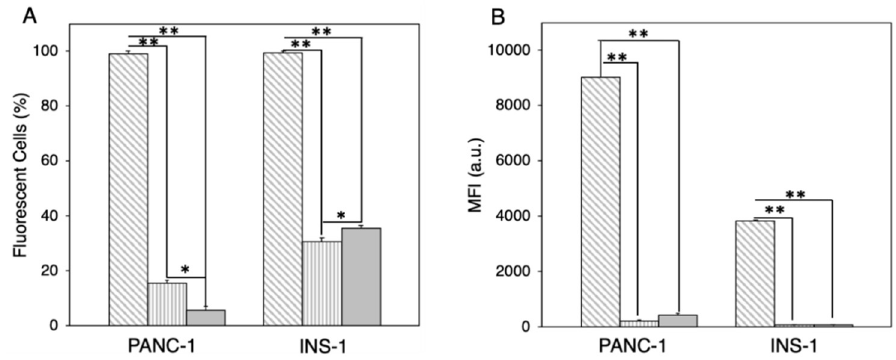
Figure 4. Relative protein abundance of biomolecular corona fingerprints. Lip-1 and Lip-5 were the liposomal formulations with the highest and lowest enrichment in PCFs (Vitronectin, APOA1, APOA2, APOB, APOC2, Ig heavy chain V-III region BRO, vitamin K-dependent protein, and Integrin